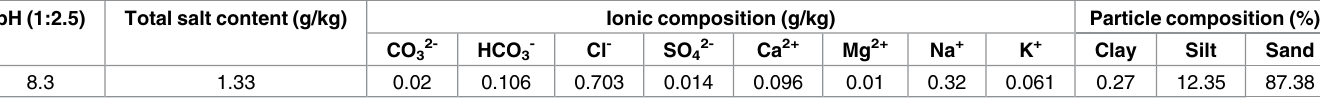
Table 1. Physicochemical properties of shifting Aeolian Sandy Soil at the study area. pH